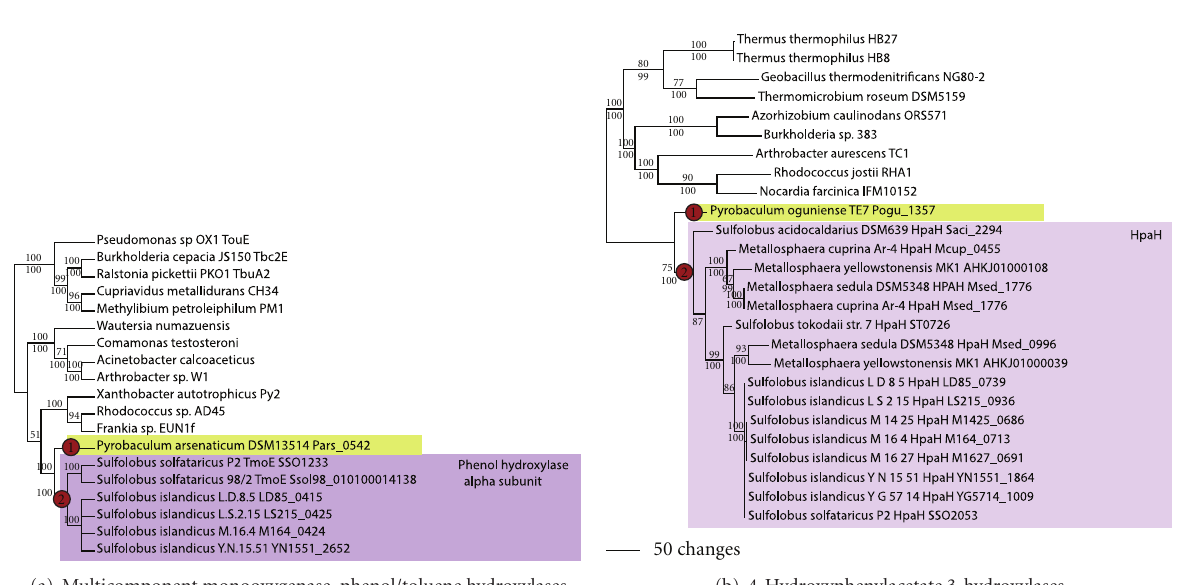
Figure 14: Phenol and phenylacetate monooxygenases. Phylogenetic trees for (a) phenol hydroxylase and (b) 4-hydroxyphenylacetate 3- hydroxylase.